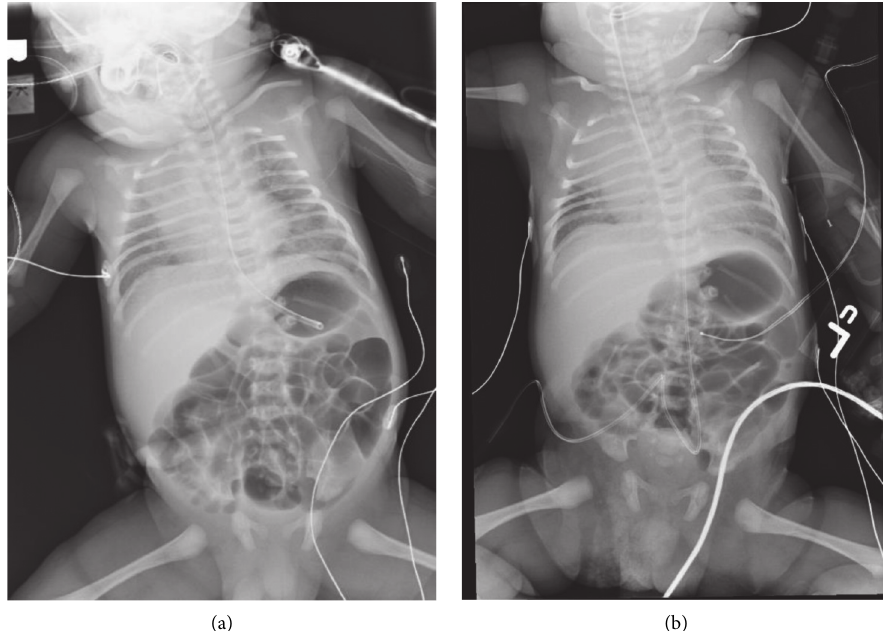
Figure 1: Radiograph of the chest and abdomen on admission. (a) The lungs are aerated bilaterally with LMA in place and show hazy parenchymal opacities bilaterally. There is a hemivertebra at T12 and 11 rib pairs on the right. (b) Similar radiograph with the esophageal tube in place in addition to removal of the nasogastric tube and placement of umbilical catheters.